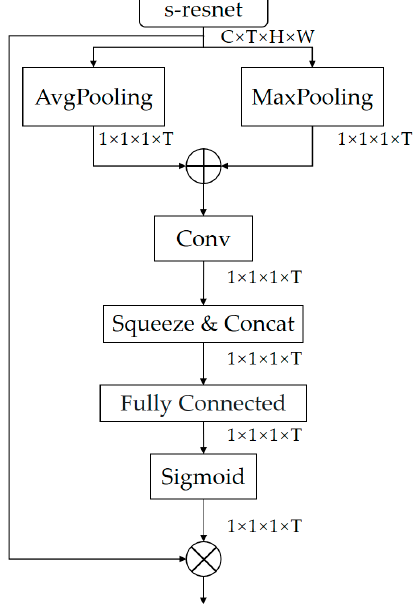
Figure 5. Frame attention module.